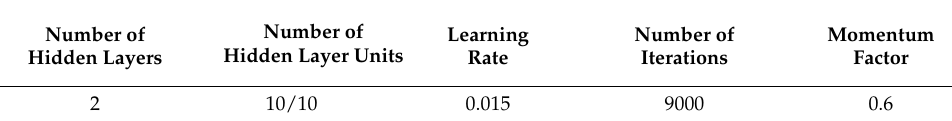
Table 6. Network parameters of the MLP model.